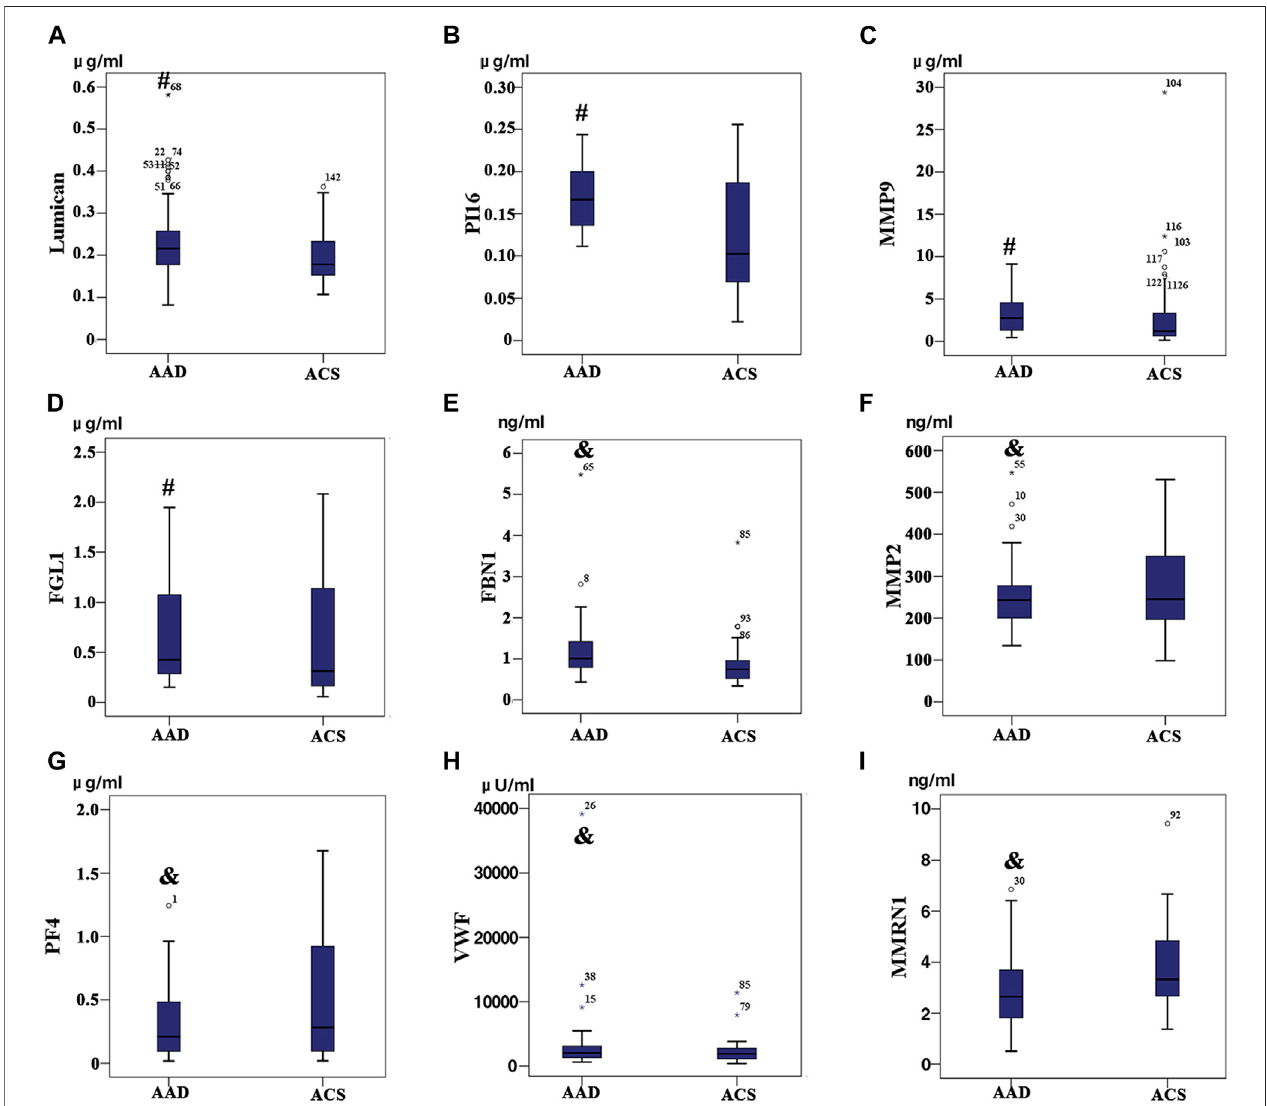
FIGURE5| Amongthepatientswithacuteaorticdissection(AAD)andAcutecoronarysyndrome(ACS), (A) Lumican, (B) Peptidaseinhibitor16, (C) Fibrinogen-like protein 1 and (D) Matrix metalloproteinase-9 expression level exhibit signi fi cant differences between the two group ( p < 0.05); (E) Pro fi brin 1 antigen (FBN1), (F) platelet factor 4 (PF4), (G) the Von Willebrand factor (VWF), (H) matrix metalloproteinase-2 (MMP-2), (I) MMRN1 ( p > 0.05) expression level did not exhibit any signi fi cant differences between the two groups ( p > 0.05).